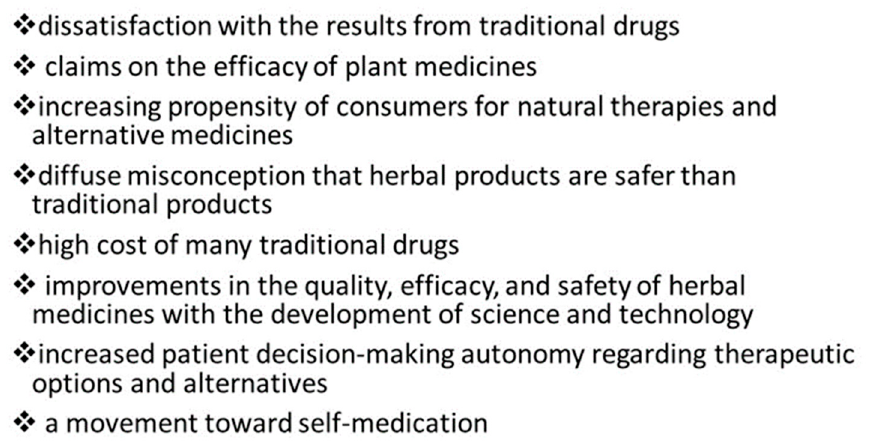
Figure 1. Factors responsible for increased use of NPs.